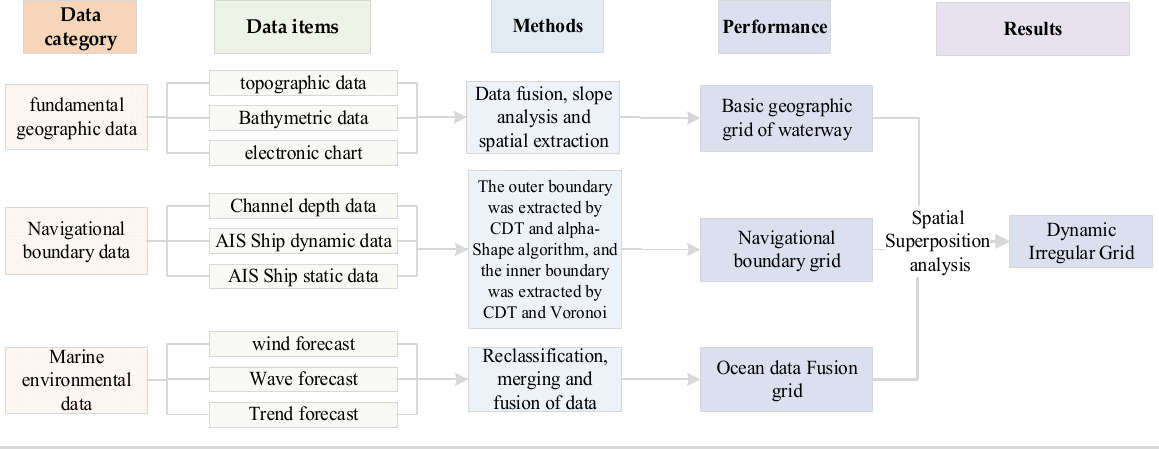
( b ) Figure 3. CDT–alpha-shape boundary extraction of waterway. ( a ) Triangulation of CDT, ( b ) alpha- shape contour extraction.